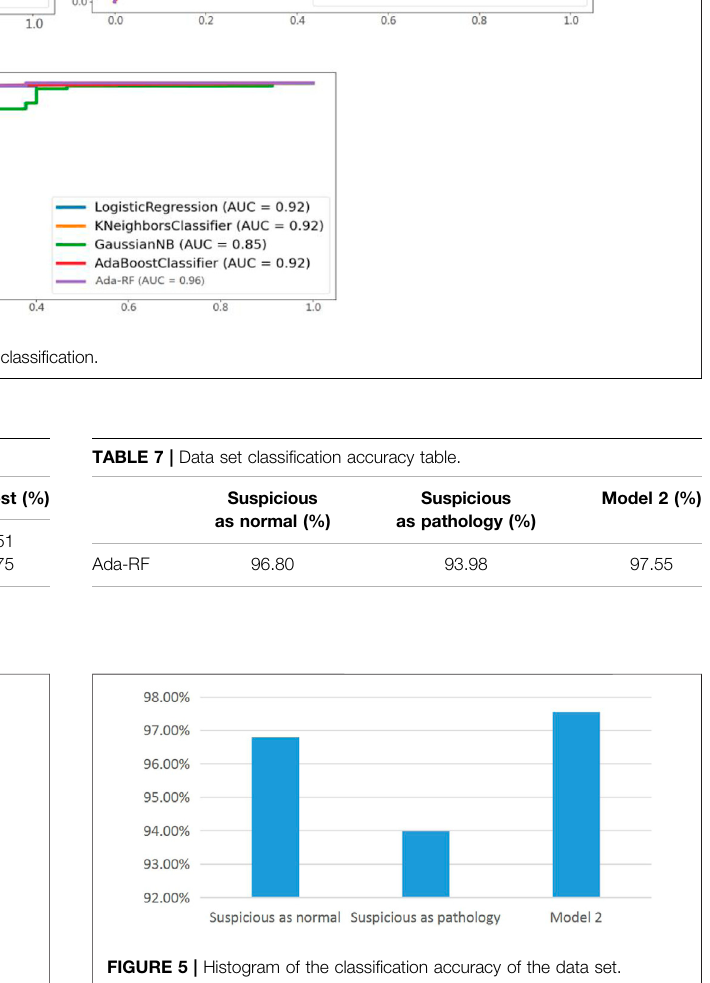
FIGURE4| Histogram oftheclassi fi cationaccuracyofpredictionresults of different models.